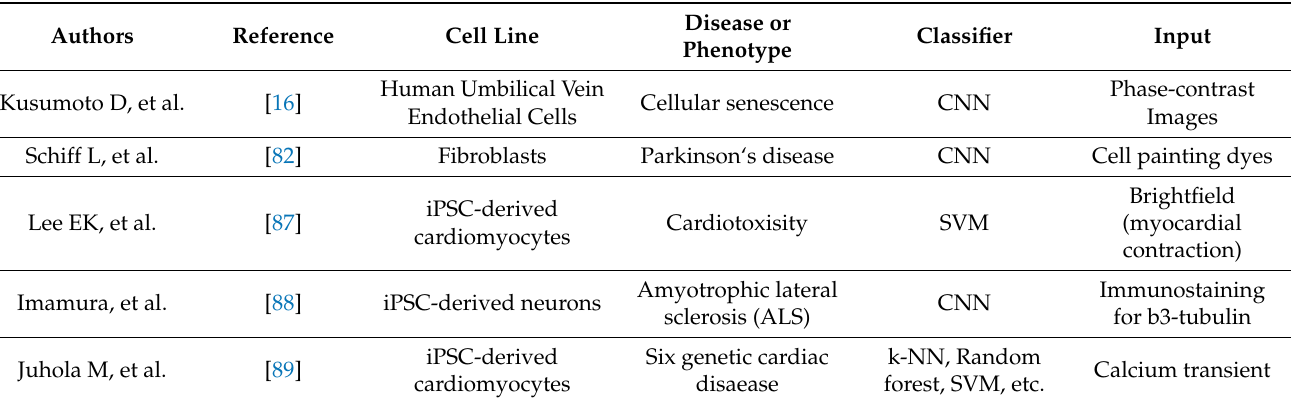
Table 1. Representative disease evaluation methods by using